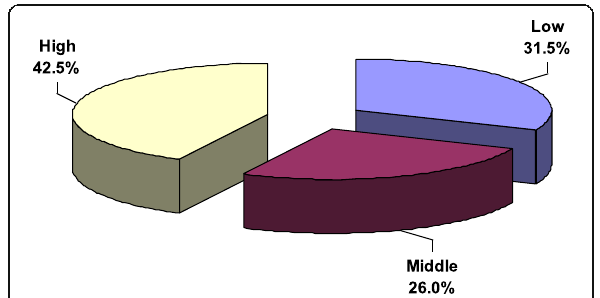
Fig. 1 Medication adherence level among studied patients, No. = 73